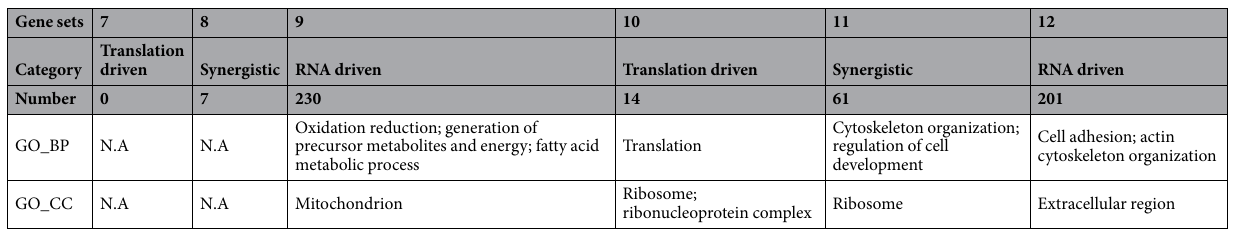
Table 2. classification of genes with regulated total translation during white adipogenesis and their associated